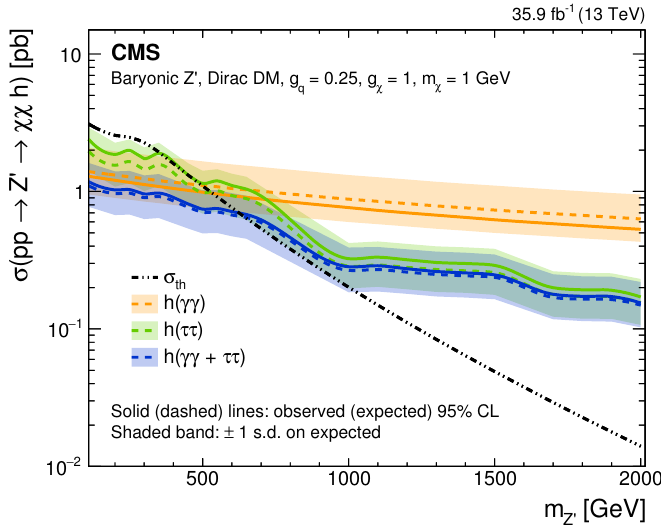
Figure 7 . Expected and observed 95% CL upper limits on the baryonic Z cross section for dark 0 matter associated production with a Higgs boson (Z ! (cid:31)(cid:31) h) are shown. Limits are given for the 0 h ! (cid:13)(cid:13) channel, h ! (cid:28) + (cid:28) channel, and their combined (cid:0)